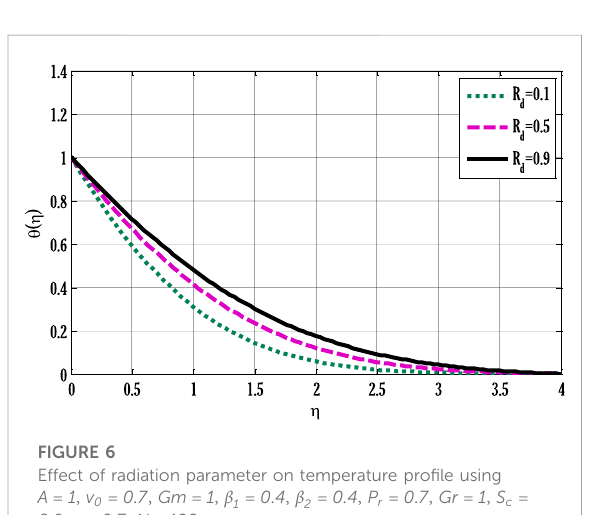
FIGURE 9 Effect of reaction rate parameter on concentration pro fi le using A (cid:1) 1 , v 0 (cid:1) 0 . 7 , Gm (cid:1) 1 , β 1 (cid:1) 0 . 4 , β 2 (cid:1) 0 . 4 , Gr (cid:1) 1 , R d (cid:1) 1 , P r (cid:1) 0 . 7 , Sc (cid:1) 0 . 9 , N (cid:1) 120